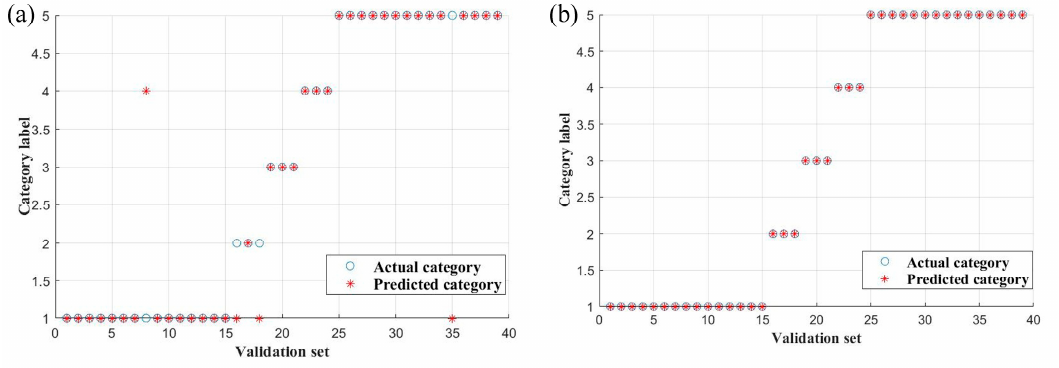
Table 1. Results of SVM models for recognizing different species of Lingzhi basing on different data matrices .